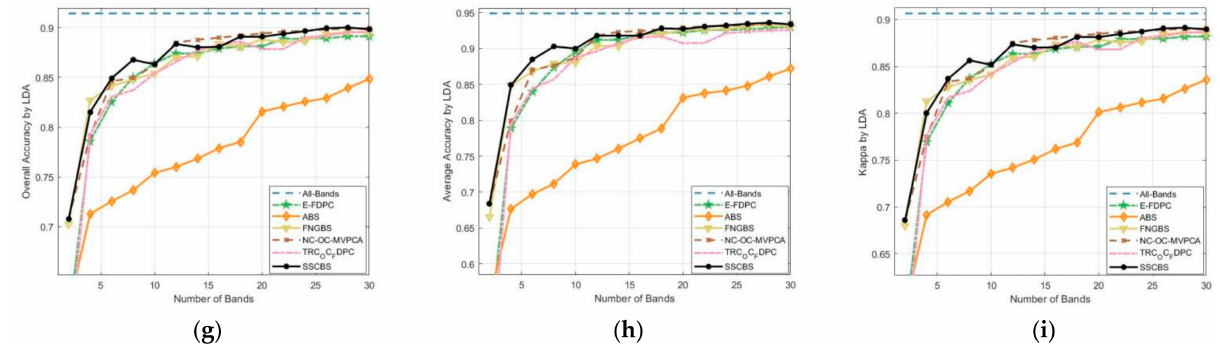
Figure 12. Classification results on Salinas data set. ( a – i ) are OA, AA and Kappa Results by SVM, KNN and LDA classifiers.